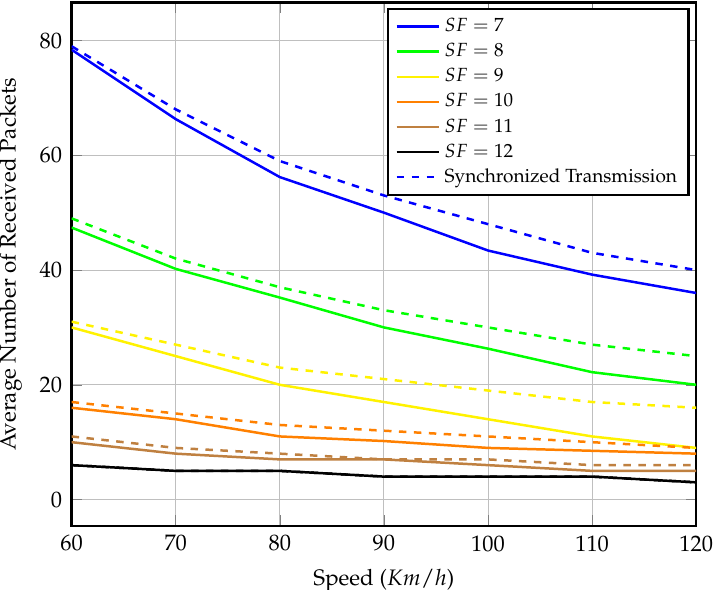
Figure 18. Average number of received packets per end-node within effective visibility time of different speeds and SF